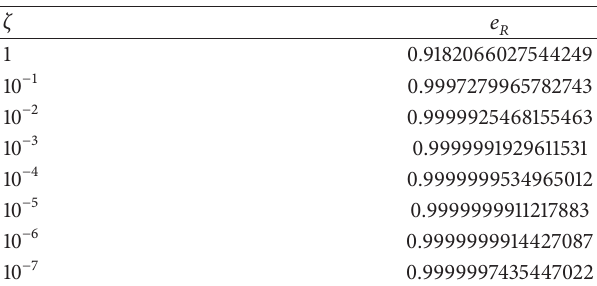
Table 3: Results of verification of 4D-Var cost function gradient for 𝑐 = 0.8 and 𝛿 x = 10 −2 × x